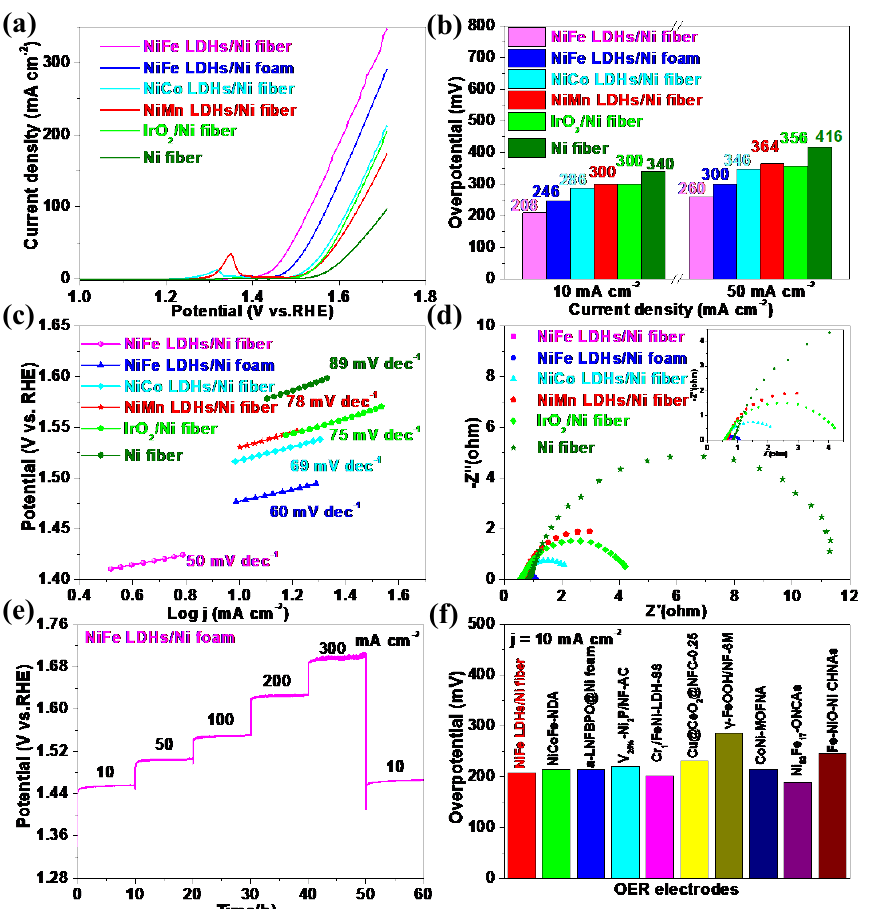
Figure 5. The OER performances were tested in a three-electrode system with 1 M KOH. ( a ) LSV curves of Ni fiber electrode, NiCo LDHs/Ni fiber electrode, NiMn LDHs/Ni fiber electrode, IrO 2 /Ni fiber electrode, NiFe LDHs/Ni foam electrode, and NiFe LDHs/Ni fiber electrode with a scan rate of 2 mV s − 1 at room temperature; ( b ) the comparison of overpotential at 10, 50, and 100 mA cm − 2 for NiFe LDHs/Ni fiber electrode; ( c ) the corresponding Tafel plots; ( d ) Nuquist plots; ( e ) chronopotentiometry curves of NiFe LDHs/Ni fiber at various current densities; ( f ) comparison of the recently OER electrode and our work with the density of 10 mA cm − 2 . Table 1. Summary of various non-noble metal catalysts for OER in alkaline solution (25 ◦ C). 5.57 mF cm −2 , which is significantly higher than that NiFe LDHs/Ni foam electrode (5.02 mF cm −2 ), NiCo LDHs/Ni fiber electrode (4.61 mF cm −2 ), NiMn LDHs/Ni fiber electrode Electrocatalysts (4.49 mF cm −2 ), and Ni fiber electrode (3.51 mF cm −2 ). The NiFe LDHs/Ni fiber electrode